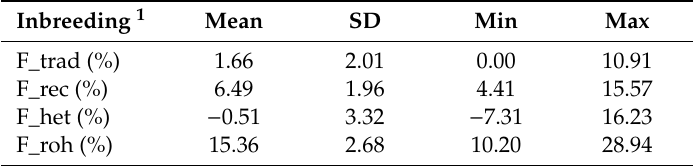
Table 5. Descriptive statistics of inbreeding values obtained using all the methods considered in the paper, from both pedigree (F_trad, F_rec) and genomic (F_het, F_roh) data.